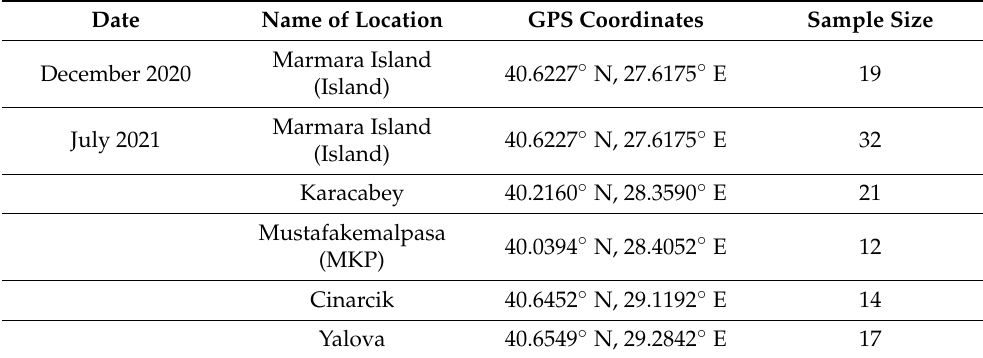
Table 1. The date, name, location, and number of colonies sampled of the five different apiaries within the Marmara region of Turkey during 2020 and 2021 for pathogen